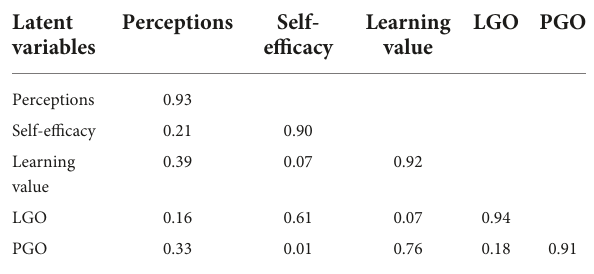
TABLE 3 Results of discriminant validity